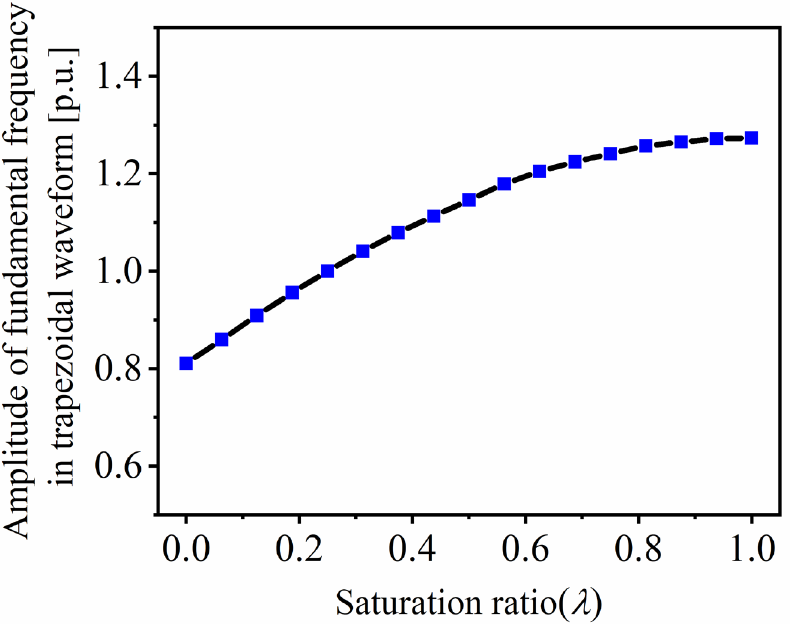
Figure 9. Relationship of the saturation ratio and the amplitude of the fundamental frequency in the trapezoidal waveform.